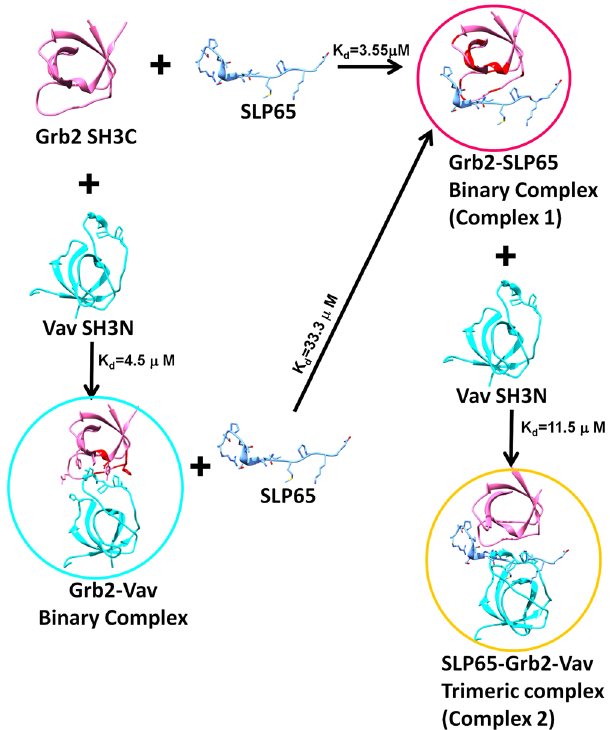
Figure 7. Schematic diagram depicting the formation of the binary and trimeric complexes. Schematic representation of the monovalent and bivalent modes of interaction of Grb2 SH3C with its ligands SLP65 and Vav. Binding of SLP65 or Vav to Grb2 SH3C results in a binary complex, Grb2-SLP65 or Grb2-Vav, respectively. Addition of SLP65 to the Grb2-Vav binary complex results in Grb2-SLP65 binary complex (Complex 1). However, the addition of Vav SH3N to the Grb2-SLP65 binary complex, gives rise to a trimeric complex (Complex 2).